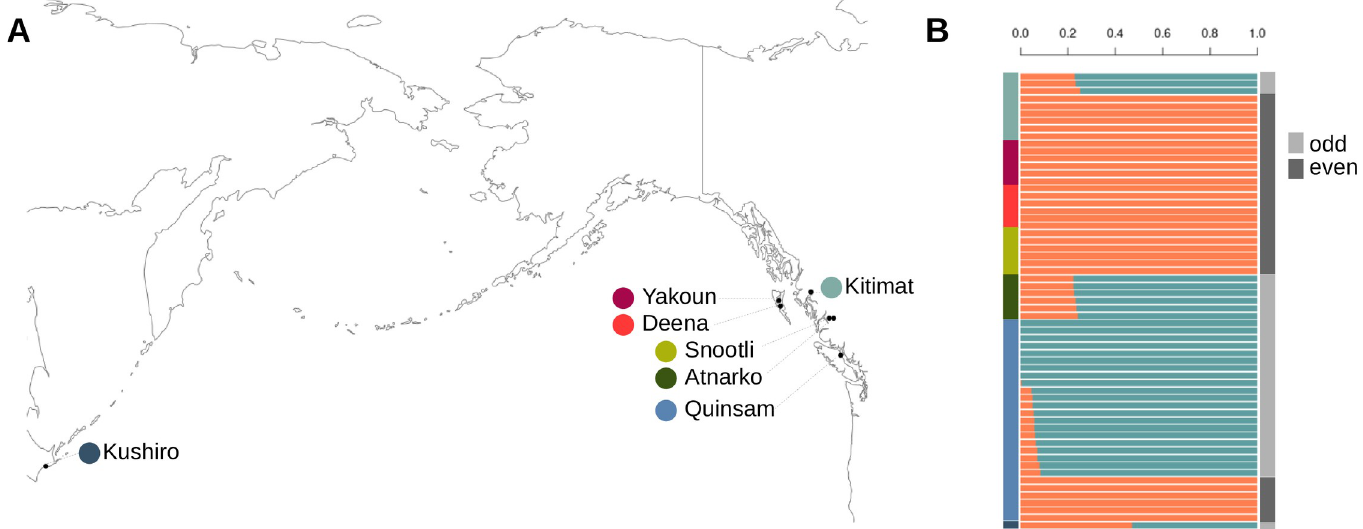
Fig 3. Population structure of pink salmon. A) Sampling locations for odd and even-year pink salmon. Map was generated in R with the maps package [115]. B) An admixture analysis based on an optimal group number of two. Sampling site is specified on the left (y-axis) by colour and fraction of alleles inherited from a lineage is shown on the x-axis (orange–even-year, blue–odd-year). On the right, DAPC groups are shown (see S1 File for group and coordinate positions). The DAPC groups matched year-class/lineage designations.